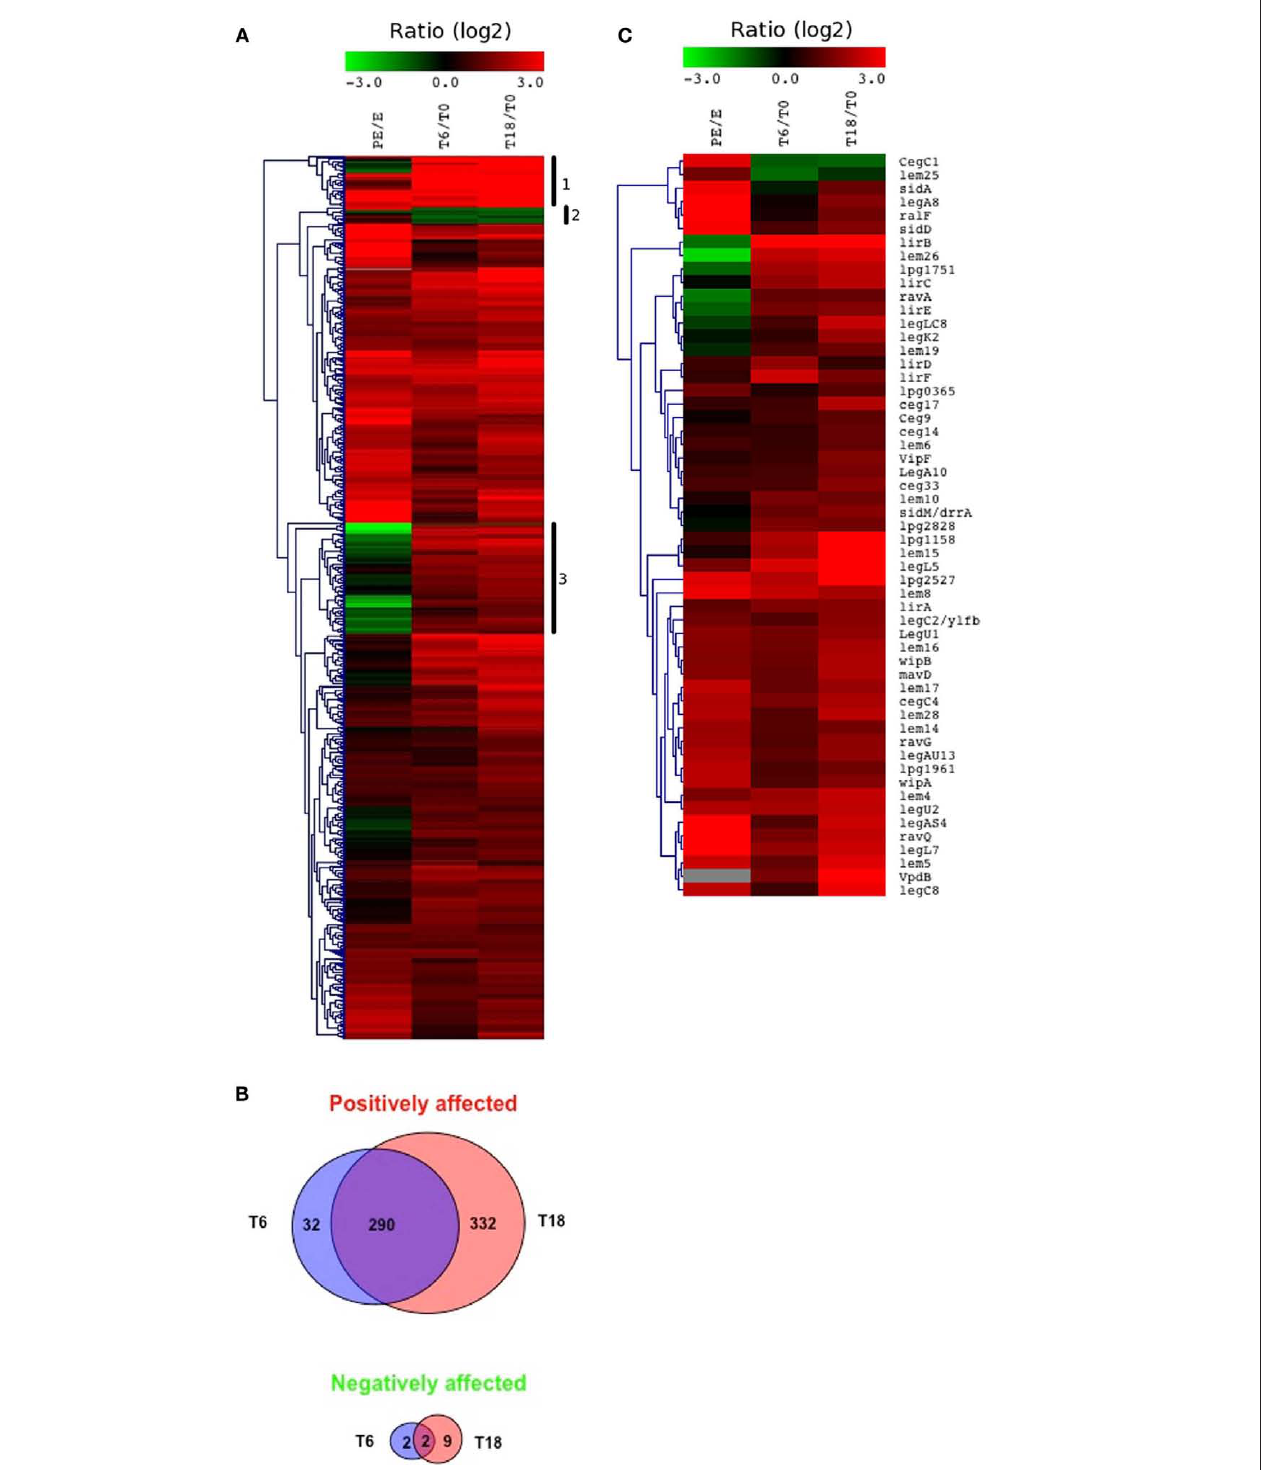
FIgURe 10 | Identification of genes differentially expressed compared to the T0 control. (a) Hierarchical clustering of the transcriptome of L. pneumophila during intracellular multiplication in THP-1 macrophages compared to intracellular growth at T0. PE phase compared to E phase is shown as a reference. Only genes with significant change in expression ( − 2 > log2 > 2,